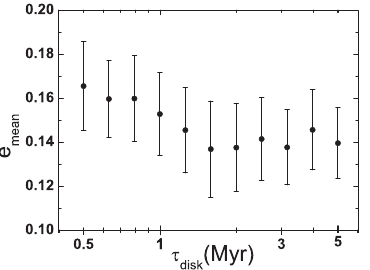
Figure 2. The influences of (cid:3) disk for e mean . e mean is decreasing with (cid:3) disk before (cid:3) disk = 2Myr, then a slight increase. The error bars are the standard error of mean.